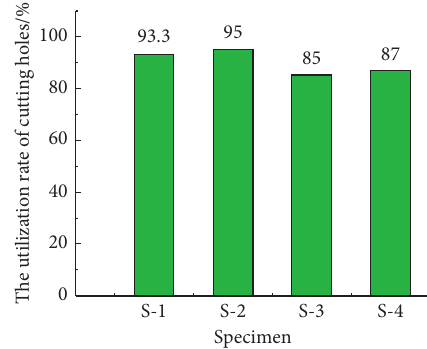
Figure 11: Utilization rate of cutting